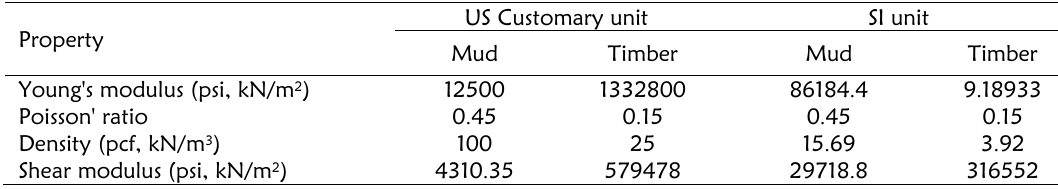
Figure 4: Arrangement of timber reinforcement in each mud block Table 1: Relevant properties of used